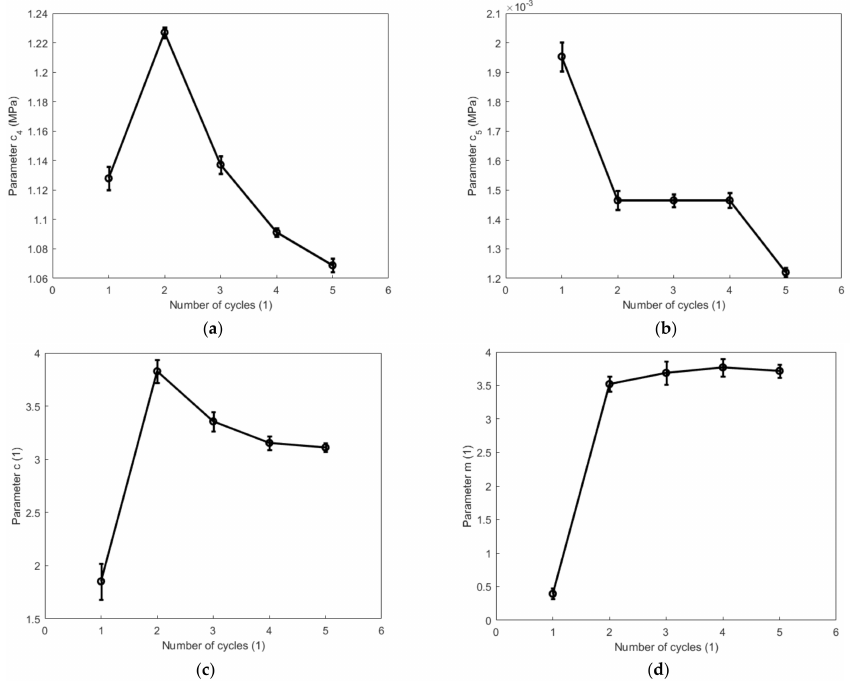
Figure 13. Evolutions of parameters c 4 , c 5 , c , and m with respect to the number of cycles during the cyclic tension process: ( a ) c 4 ; ( b ) c 5 ; ( c ) c , and ( d ) m .